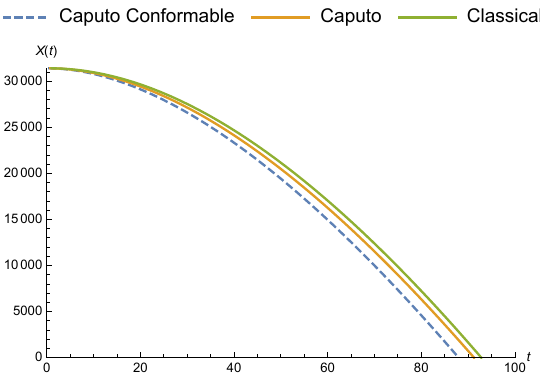
Figure 2. Comparative analysis of the vertical motion of a falling body with different types of derivatives while α = 0.95, β =